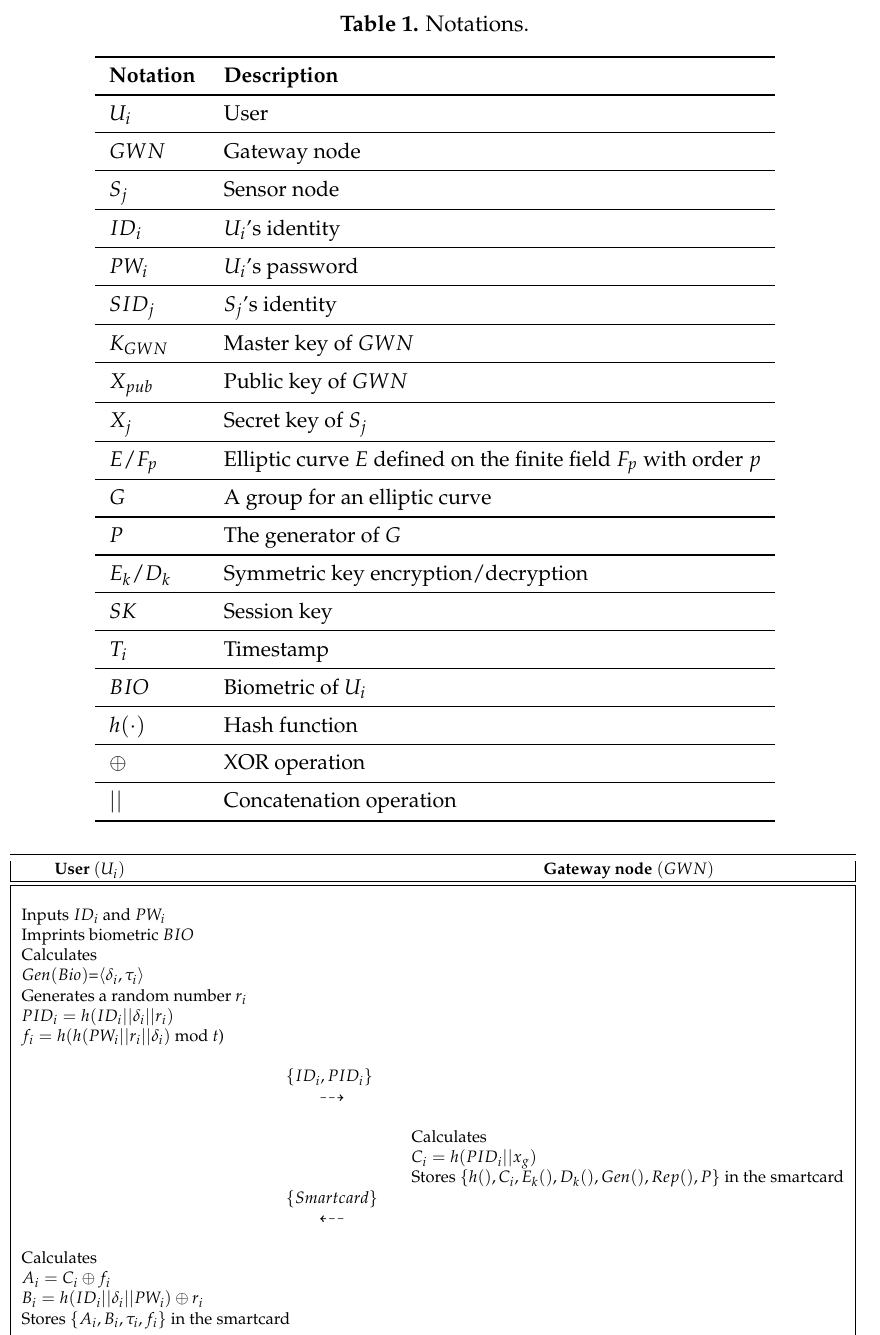
Table 1. Notations.